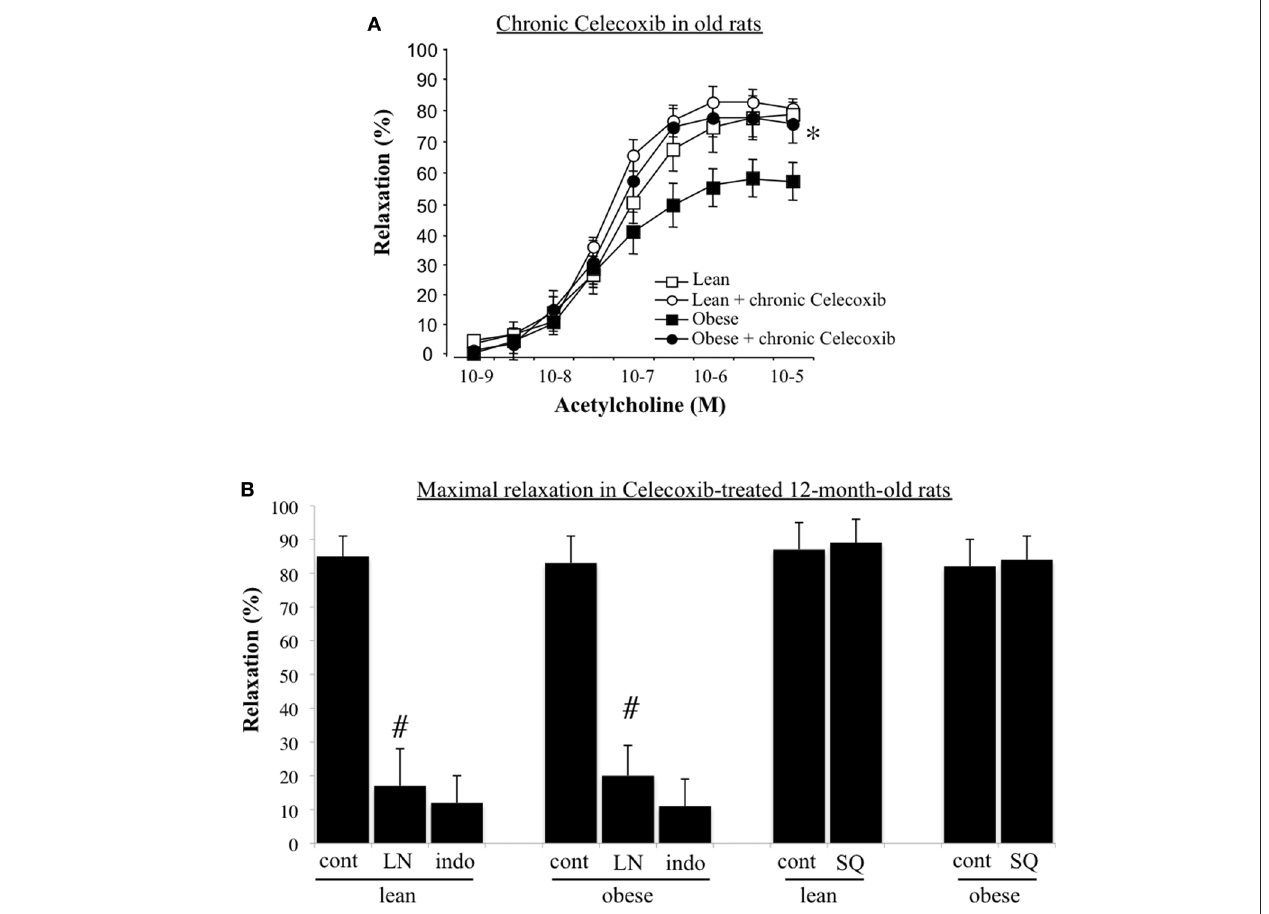
Figure 6 | Acetylcholine-mediated relaxation in mesenteric resistance arteries isolated from or old lean and obese Zucker rats (A). Rats were treated chronically with the COX2 inhibitor Celecoxib or its solvent. Mean ± SEM is presented ( n = 8 per group). Acetylcholine-mediated